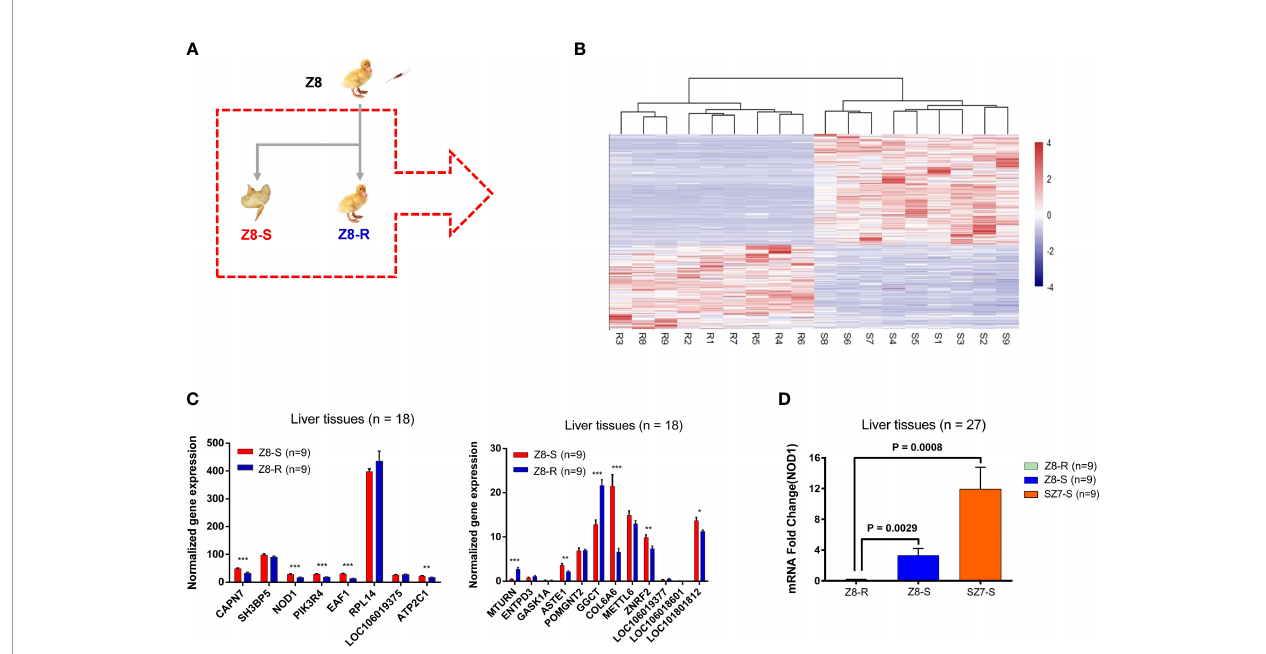
FIGURE 3 | NOD1 is a candidate gene for the susceptibility trait. (A) Images are from individuals of fl ock Z8. The images in the dashed box show the selection of animal materials used in this study for transcriptome sequencing. (B) Heat map analysis classifying the gene expression patterns of DEGs. (C) Gene expression levels in candidate intervals determined by the transcriptome analysis of liver samples. Statistical analysis was performed by using Student ’ s t-test, and error bars indicate the standard error of the mean (SEM). The results are presented as the means ± SEM of at least three independent experiments. * P < 0.05; ** P < 0.01; *** P < 0.001. (D) qPCR was used to determine the expression of NOD1 in liver tissues from Z8-R (n = 9), SZ7-S (n = 9) and Z8-S (n = 9)